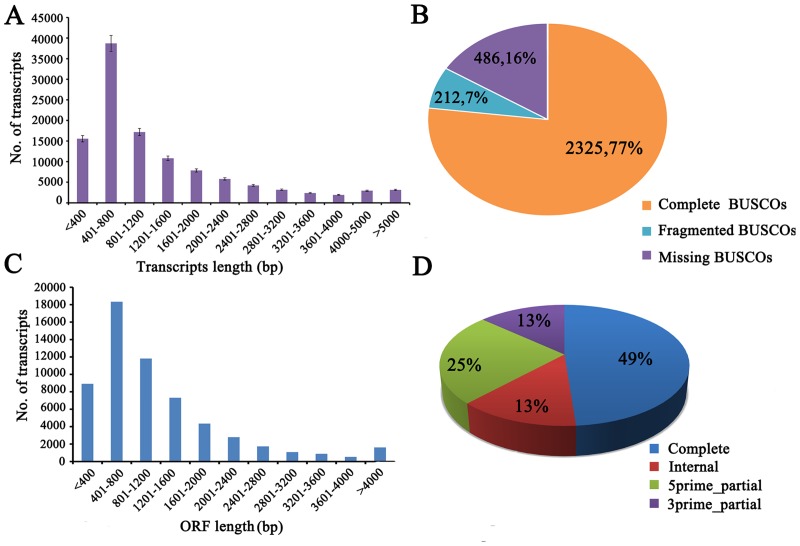
Assessment of Eurasian perch transcriptome assembly and annotation.(A). Histogram of transcripts length distribution. (B). Evaluation of the transcriptome assembly based on vertebrate data set through BUSCO software. (C). Histogram of ORF length distribution. (D). Statistics on ORF completeness.